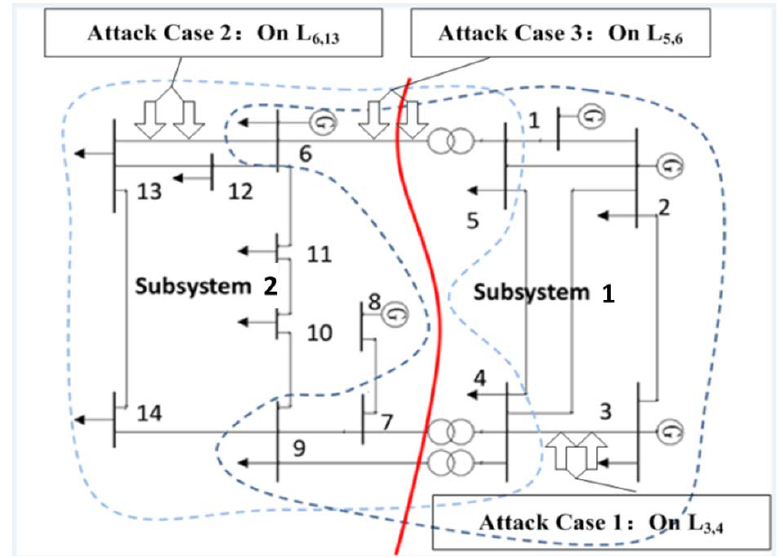
Figure 3. Attack cases on IEEE 14-bus